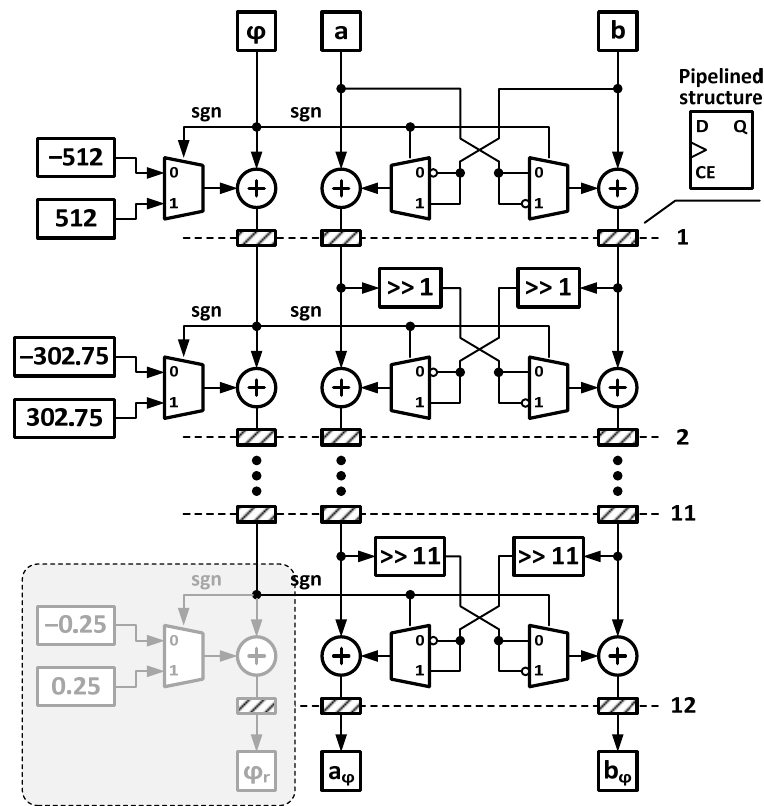
Figure 9. The coordinates rotation computation unit based on CORDIC algorithm.